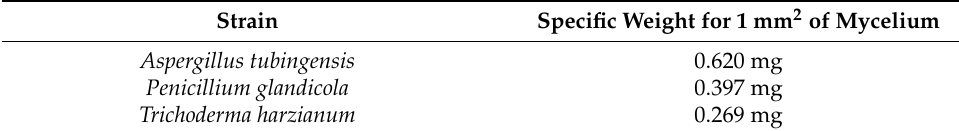
Table 3. Specific weight of 1 mm 2 of mycelium of each species tested.